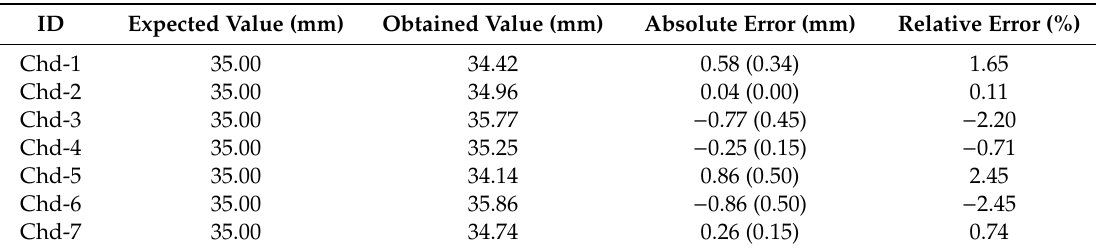
Figure 8. Invariants (target diameters) used to scale and check the photogrammetric model accuracy. The diameters used to scale (Cd) are shown in red, and the diameters used to check the accuracy (Chd) are shown in blue. Table 3. Accuracy of the photogrammetric model in terms of target diameters (re-projection error). The error in pixels is provided in parentheses. ID—identifier.